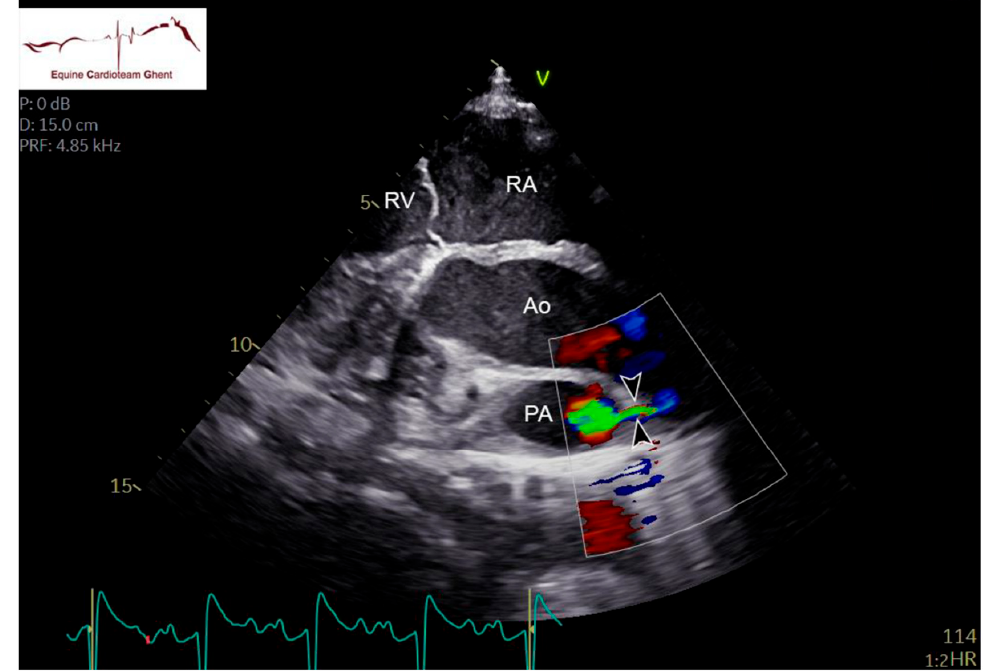
Figure 4. Color flow Doppler of the ductus arteriosus ( arrowheads ) in a 2-day-old healthy foal on the right parasternal slightly cranially angled R-RVOT view. Ao: aorta; PA: pulmonary artery; RA: right atrium; RV: right ventricle.